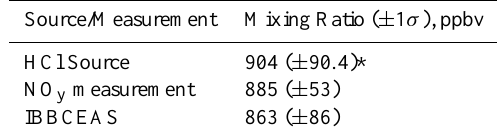
Table 2. Results of the HONO source calibration.